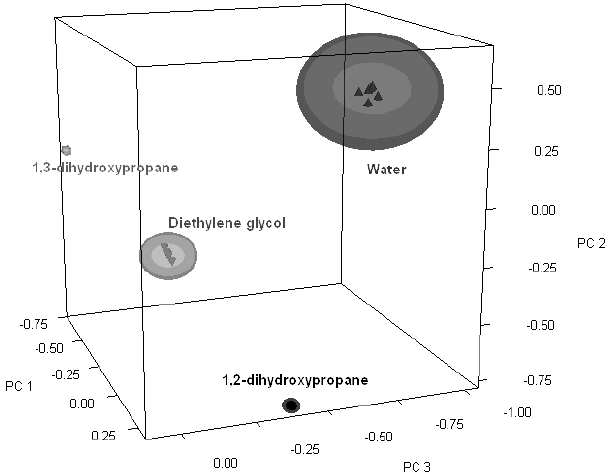
Fig. 2. Principal component score plot of the NIR spectra of each group in the identi¯cation method for DEG raw material.